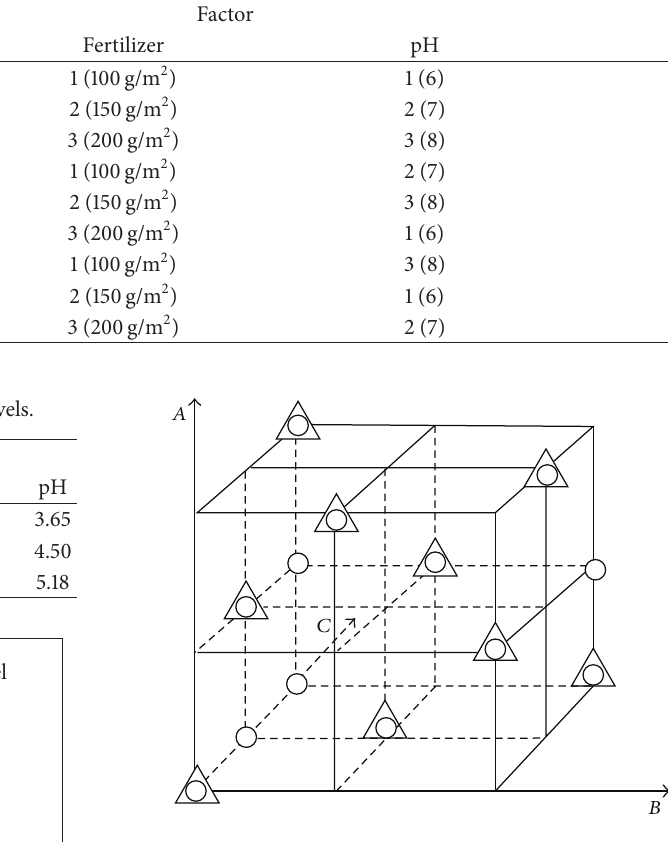
Figure 1: Schematic diagram of orthogonal experimental design.